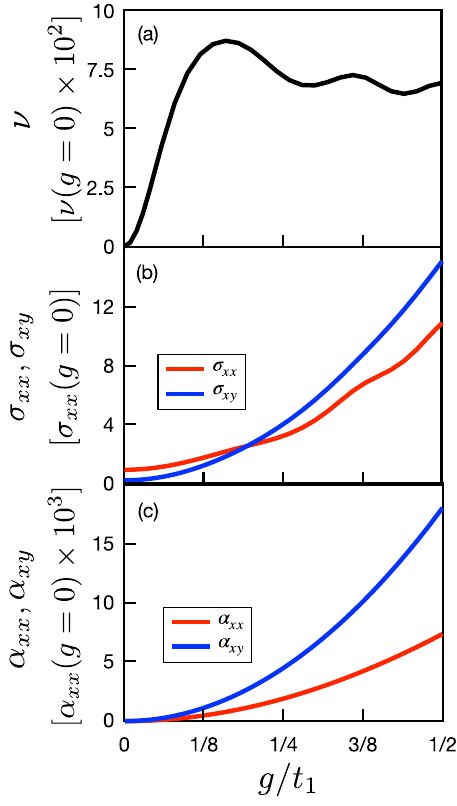
Fig. 5 Transport coef fi cients. Calculated Nernst coef fi cient and transport components as a function of the strength g of the nematic = 0.01. a Calculated Nernst coef fi cient fl uctuations for μ = 1 and k B T ν . Starting from very small values ν increases dramatically already for relatively small values of g . b Electrical conductivity σ xx (red line) and Hall conductivity σ xy (blue line) as a function of g . The Hall coef fi cient grows more rapidly than σ xx and eventually exceeds its absolute value at g / t 1 ≈ 0.2. This causes for ν a change from a strong increase followed by a saturation. c Peltier coef fi cients α xx (red line) and α xy (blue line) as a function of g . Also here, the anisotropic component is dominant in the presence of nematic fl uctuations.